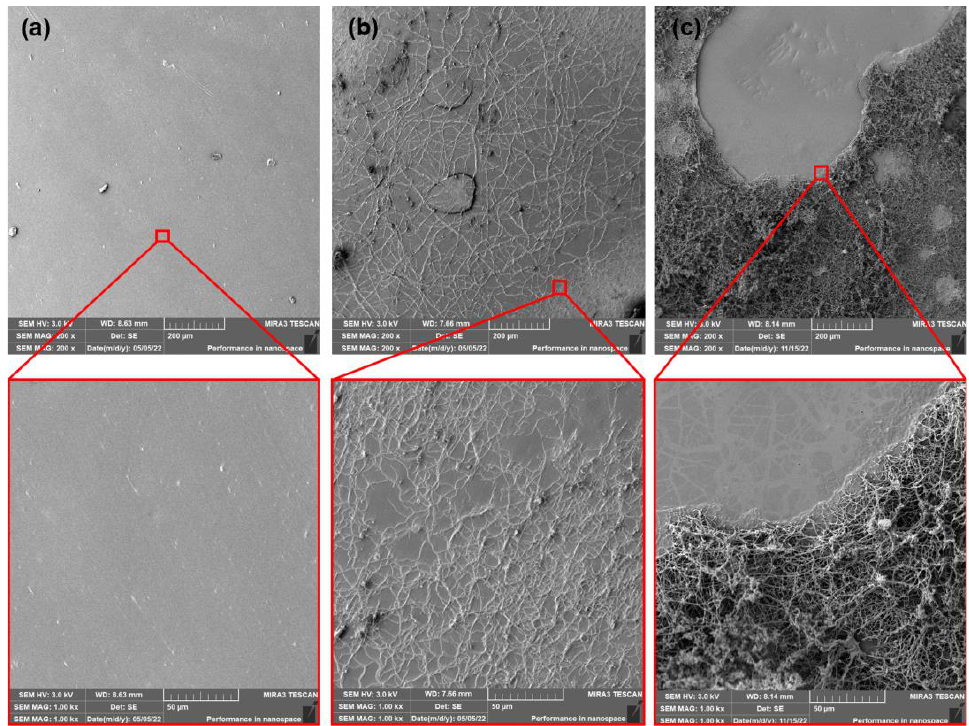
Figure 14. SEM images of as-produced PLA/MC2192 films ( a ) at initial state and after ( b ) 14 days of thermophilic composting, and ( c ) 28 days of thermophilic composting.